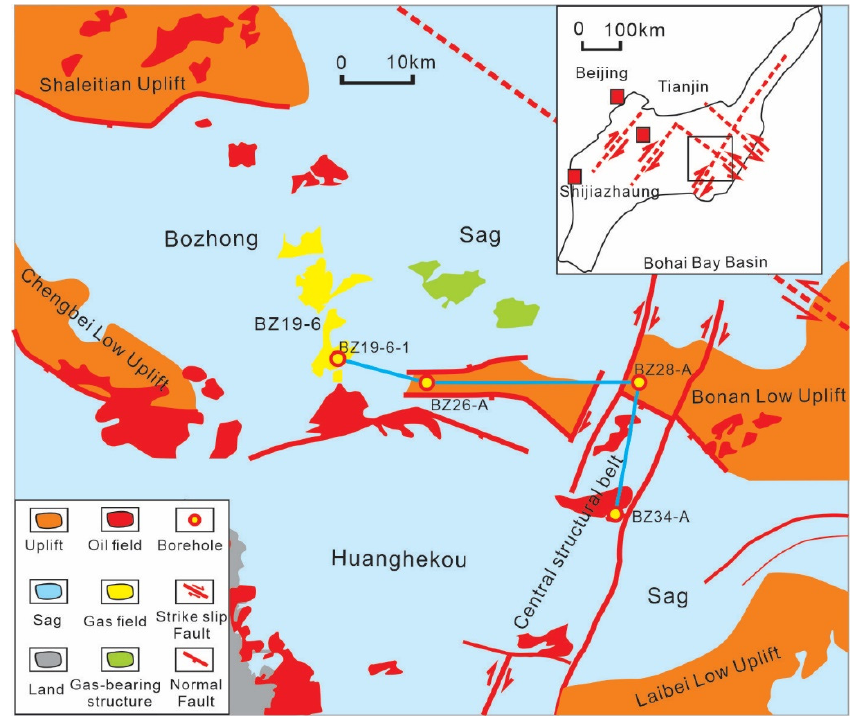
Figure 1. Geological map of the study area showing major tectonic elements, oil-gas bearing struc- tures, and boreholes.